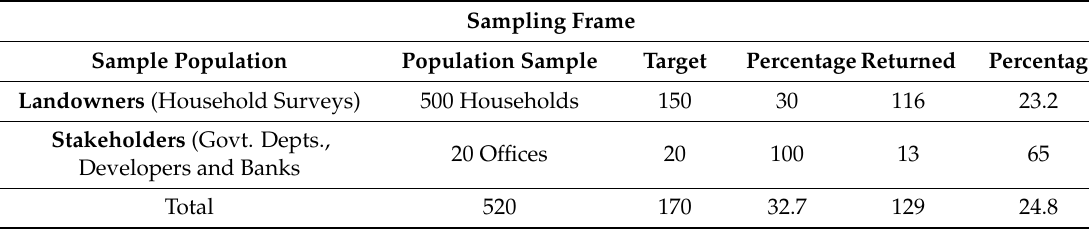
Table 3. Summary of the Sample Population Groups (Landowners and Stakeholders).